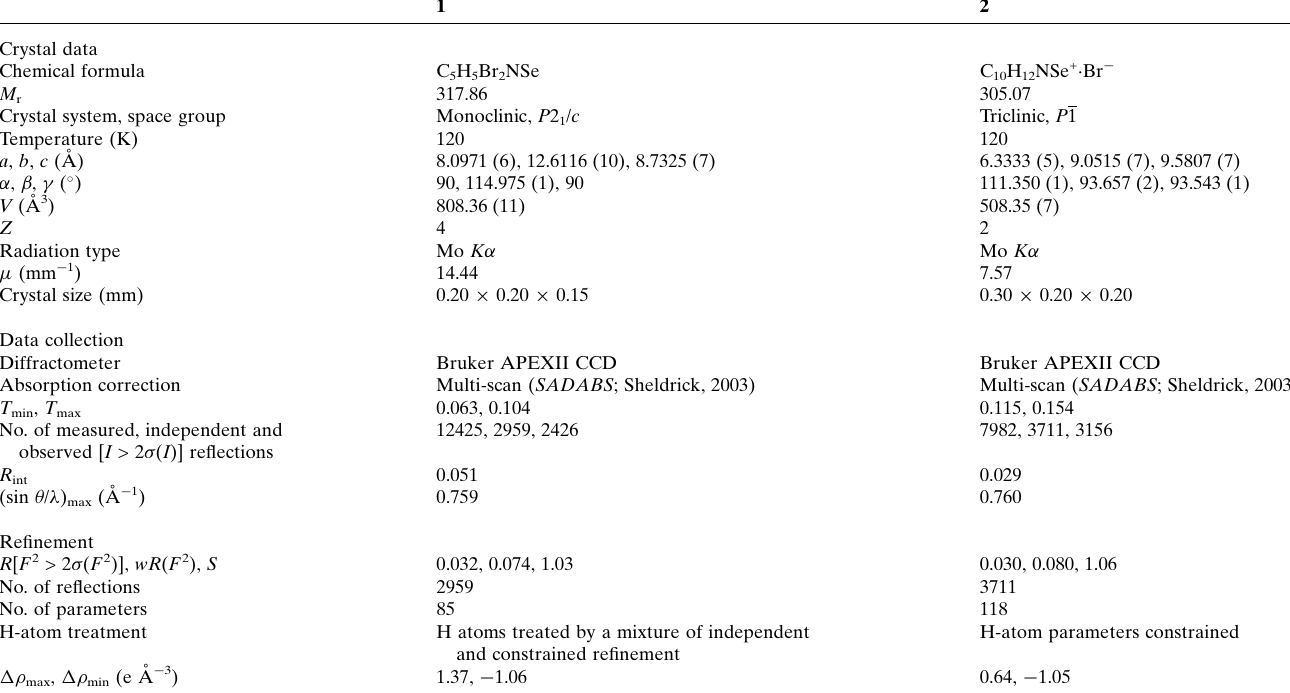
Crystal data Chemical formula